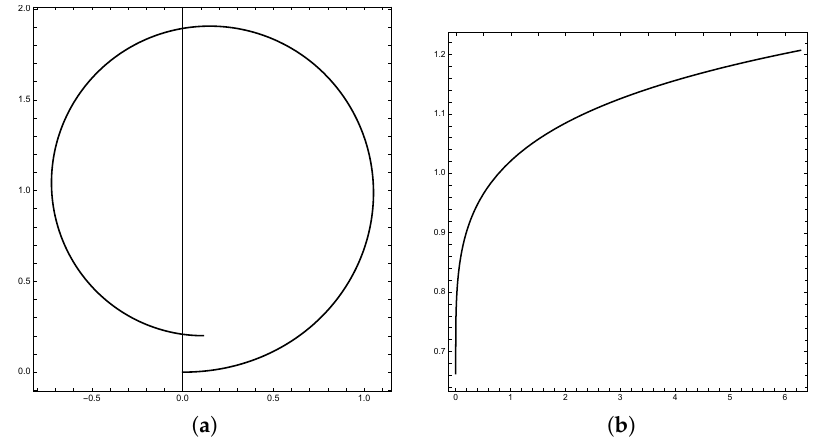
Figure 4. ( a ) Curv with ρ ( θ ) = U ( 0.1,0.8, θ ) , 0 ≤ θ ≤ 2 π , ( b ) curvature.